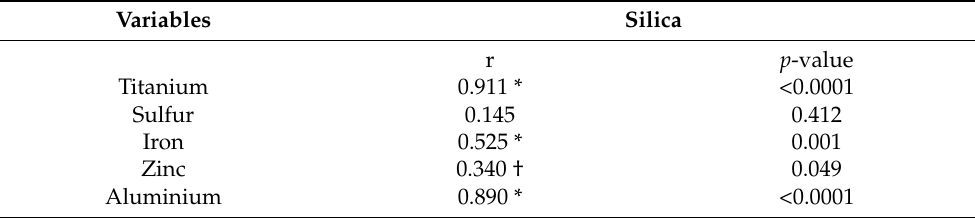
Table 4. Correlation between silica and other mineral contents in lung tissues (34 patients).